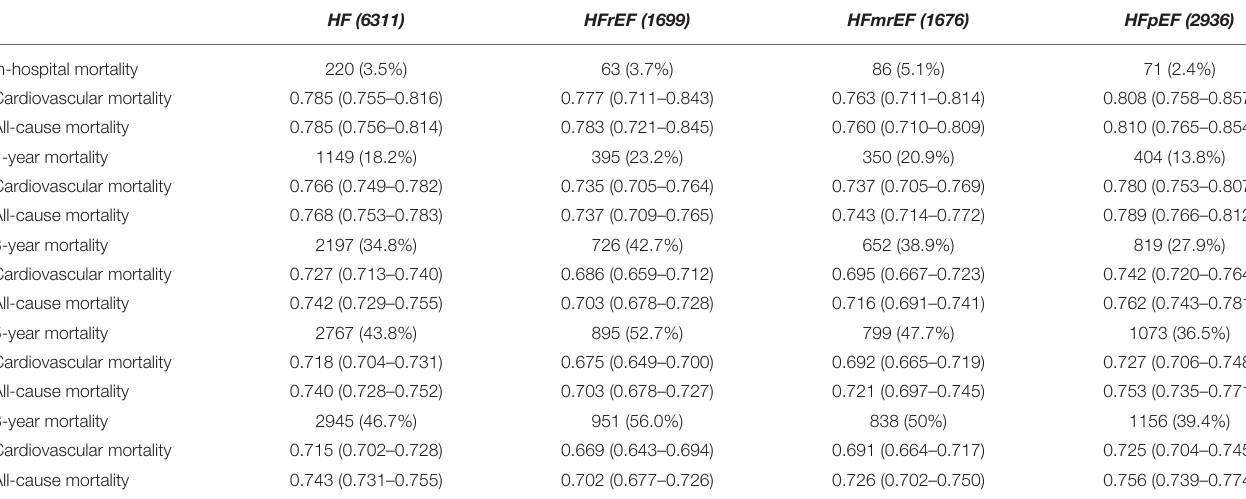
TABLE 4 | The AUC of Cys-C/PAB ratio combined with NT-proBNP for clinical outcomes